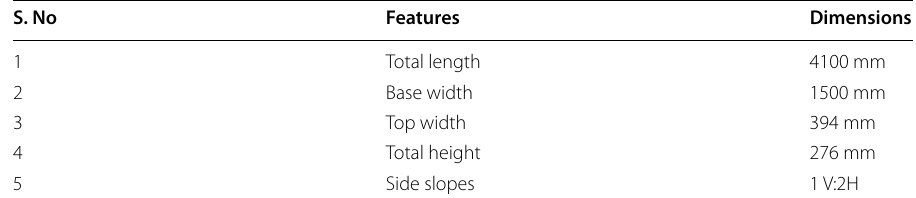
Table 4 Dimension of the lab model